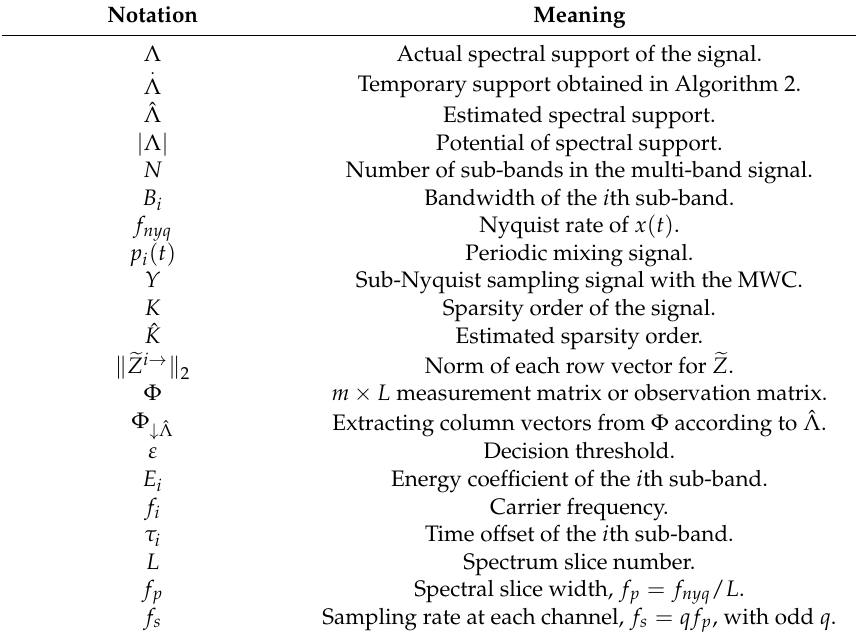
Table 1. List of the